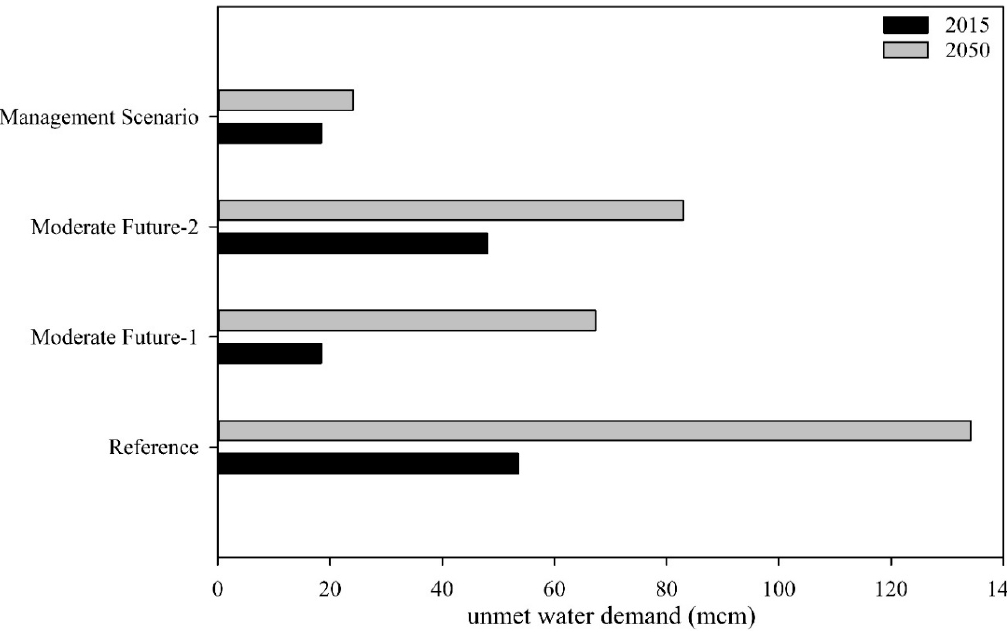
Figure 18. The unmet water demand for four different futures for the years of 2015 and 2050.